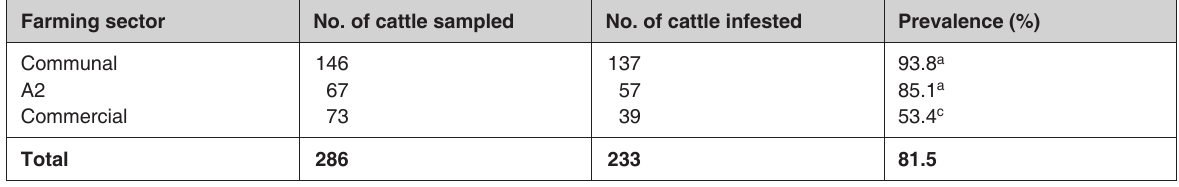
TABLE 1 Number of cattle infested with ticks and the prevalence of tick infestation according to farming sector Farming sector